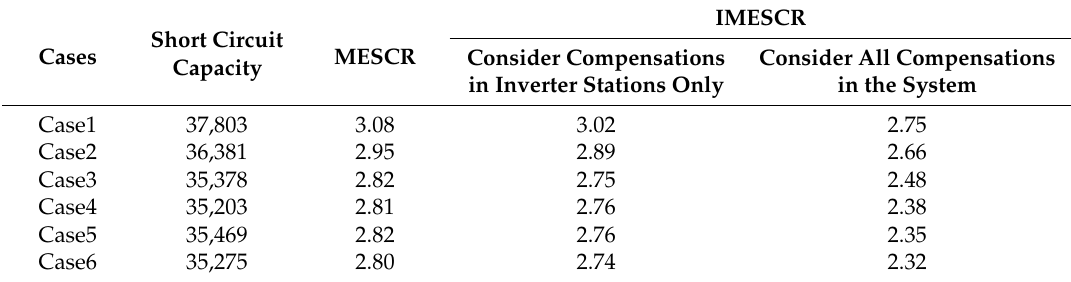
Table 6. MESCR and IMESCR for All Cases of the Eastern China Grid.